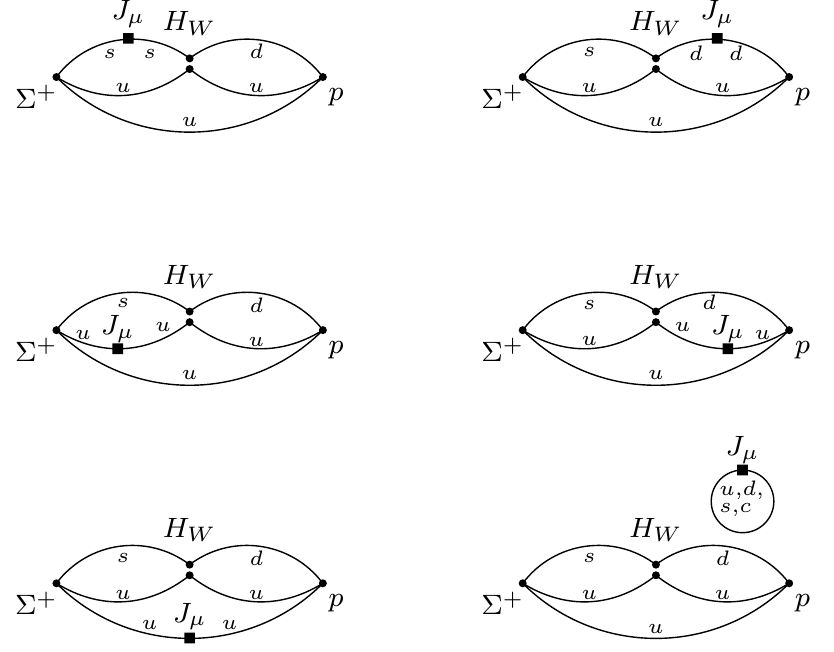
Figure 3 . Four-point diagrams for the C sd class. The squared vertex shows the insertion of the electromagnetic current J µ